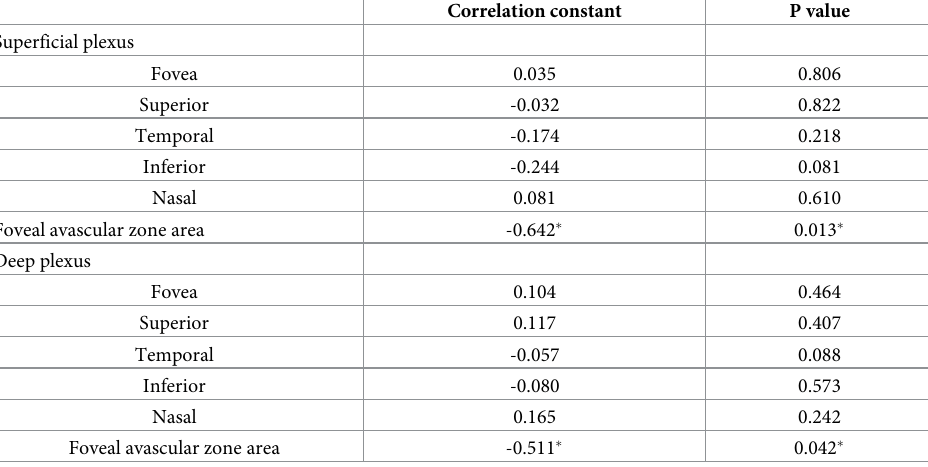
Table 3. Correlation between optical coherence tomography angiography and visual acuity in patients with Mac- Tel type